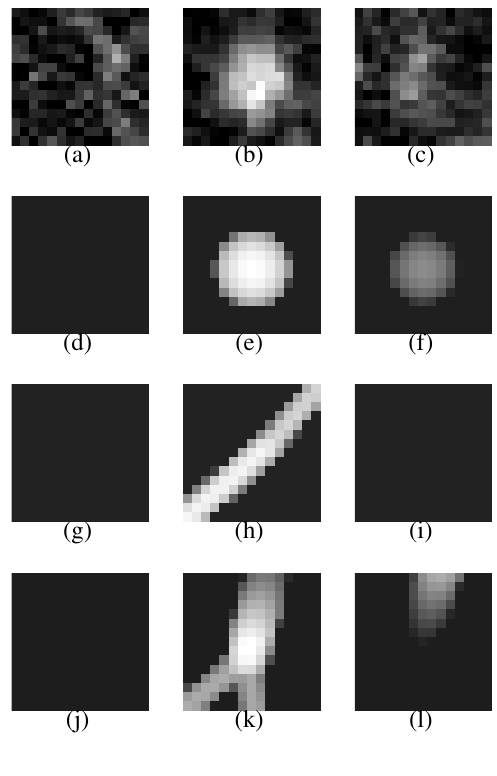
Figure 7. The first row represents the VOI comprising the nodule shown in Figure 6. The second, third and fourth rows represent the templates that are produced from the most likely nodule, curved blood vessel and bifurcated blood vessel models, respectively.